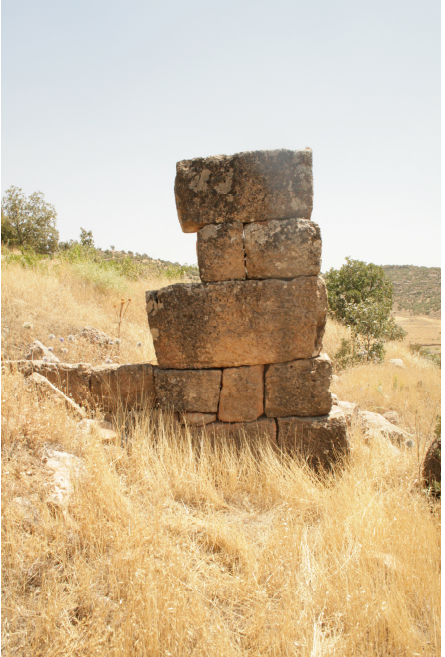
Fig. 7. Keferde, the wall on the southwestern slope with a corner showing trapezoidal masonry technique. View from the W. Photo: Minna Silver 2016.